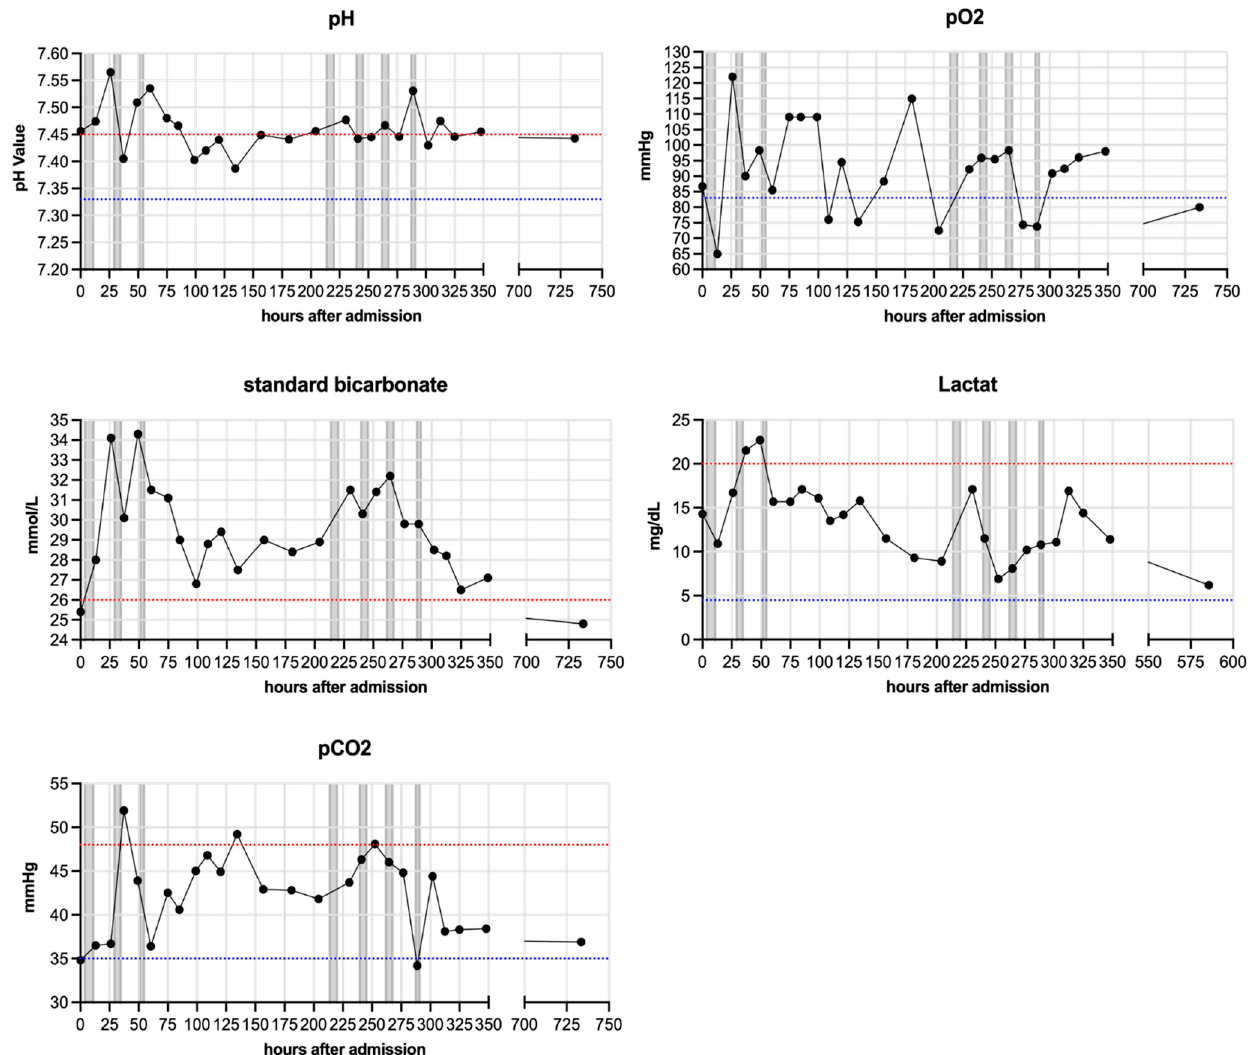
Figure 3. Respiratory parameters of one patient (patient 4). pH, standard HCO 3 − , lactate, arterial pCO 2 and pO 2 were measured regularly for each patient and are depicted here representatively for patient 4. Blue lines indicate minimum baseline and red lines maximum baseline for each normal range. Grey bars indicate apheresis treatments.